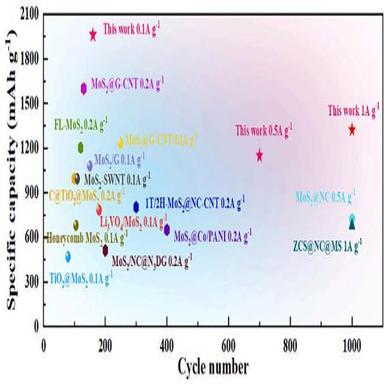
Capacity pairs at different current densities.